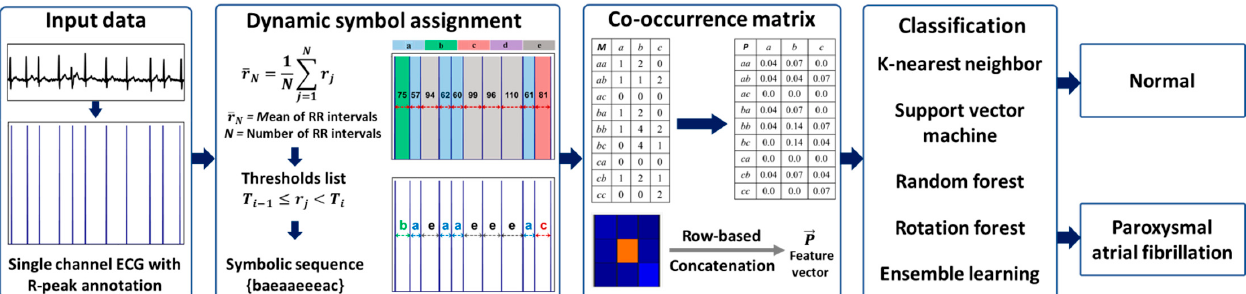
Figure 1. The overall pipeline of the proposed approach. The interbeat (RR) intervals are applied to dynamic symbol assignment (DSA) to map electrocardiography (ECG) signals to a symbolic sequence. The thresholds T i is used to maps the symbols in the RR interval. The pattern transition probability P is computed from co-occurrence pattern transition matrix M for symbols { a , b , c } . Finally, the P is transformed to a 1-dimensional array P using row-based concatenation, and the DSA features are extracted. The DSA features are fed to the k-nearest neighbor (kNN), support vector machine (SVM), random forest (RF), rotation forest (RoF), and ensemble learning (EL) classifiers to differentiate normal and paroxysmal atrial fibrillation (PAF) segments. The dark-blue arrow refers to the flow from one process to the next. The grey arrow refers to the intermediate outcome of the